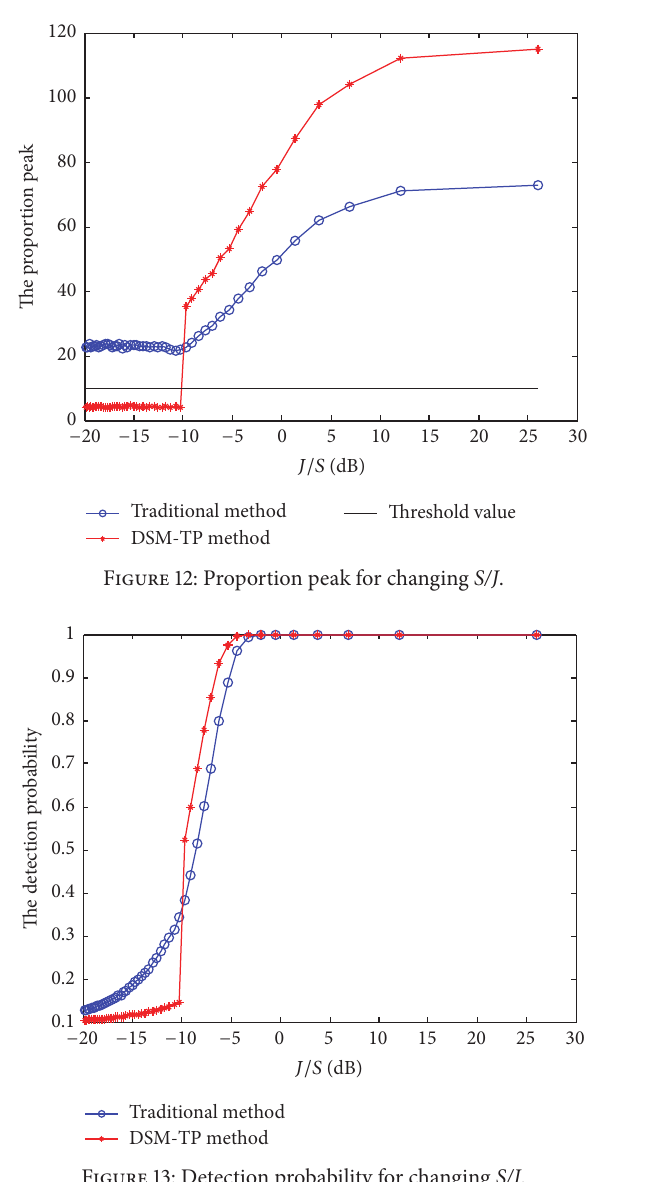
Figure 15: Detection probability for changing S/J